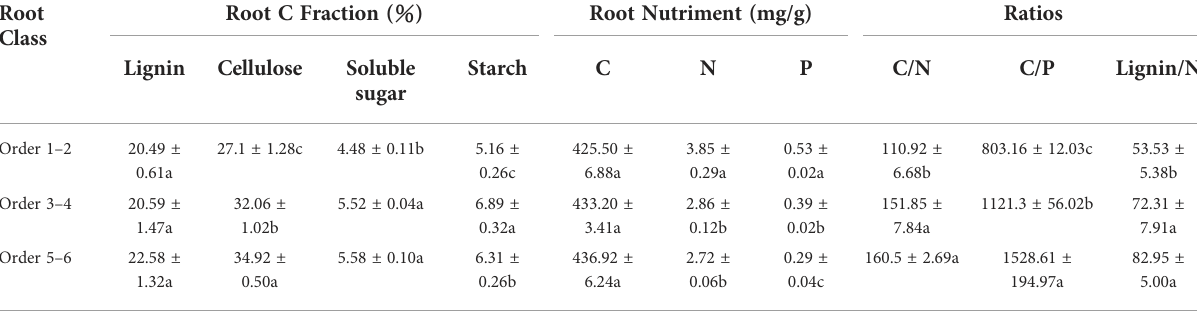
TABLE 1 Initial chemistry of the fi ne roots in Pinus massoniana